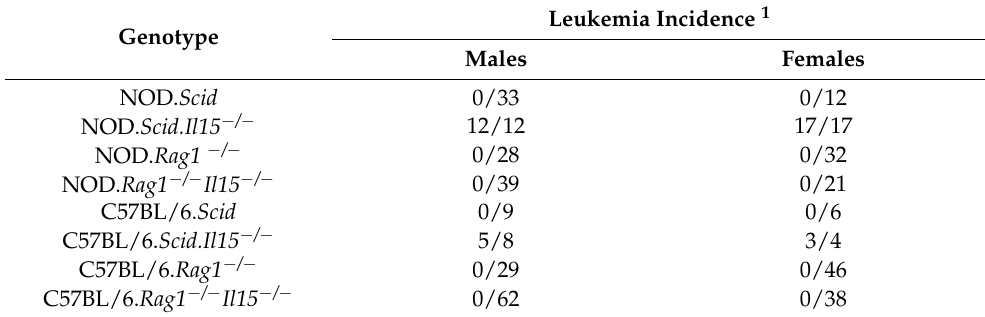
Table 1. Scid mutation but not RAG1 deficiency promotes leukemogenesis in the absence of IL-15.